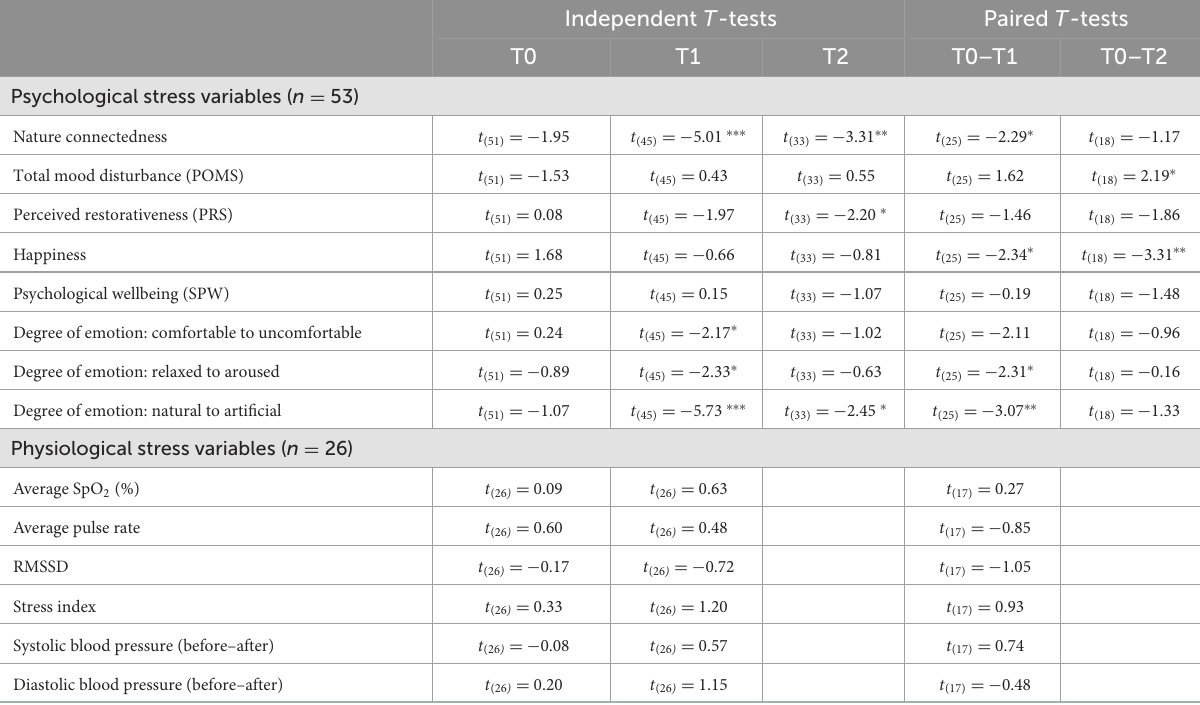
TABLE 3 Between-subject and within-subjects comparison of the psycho-physiological stress variables at T0, T1, and T2. Independent T -tests